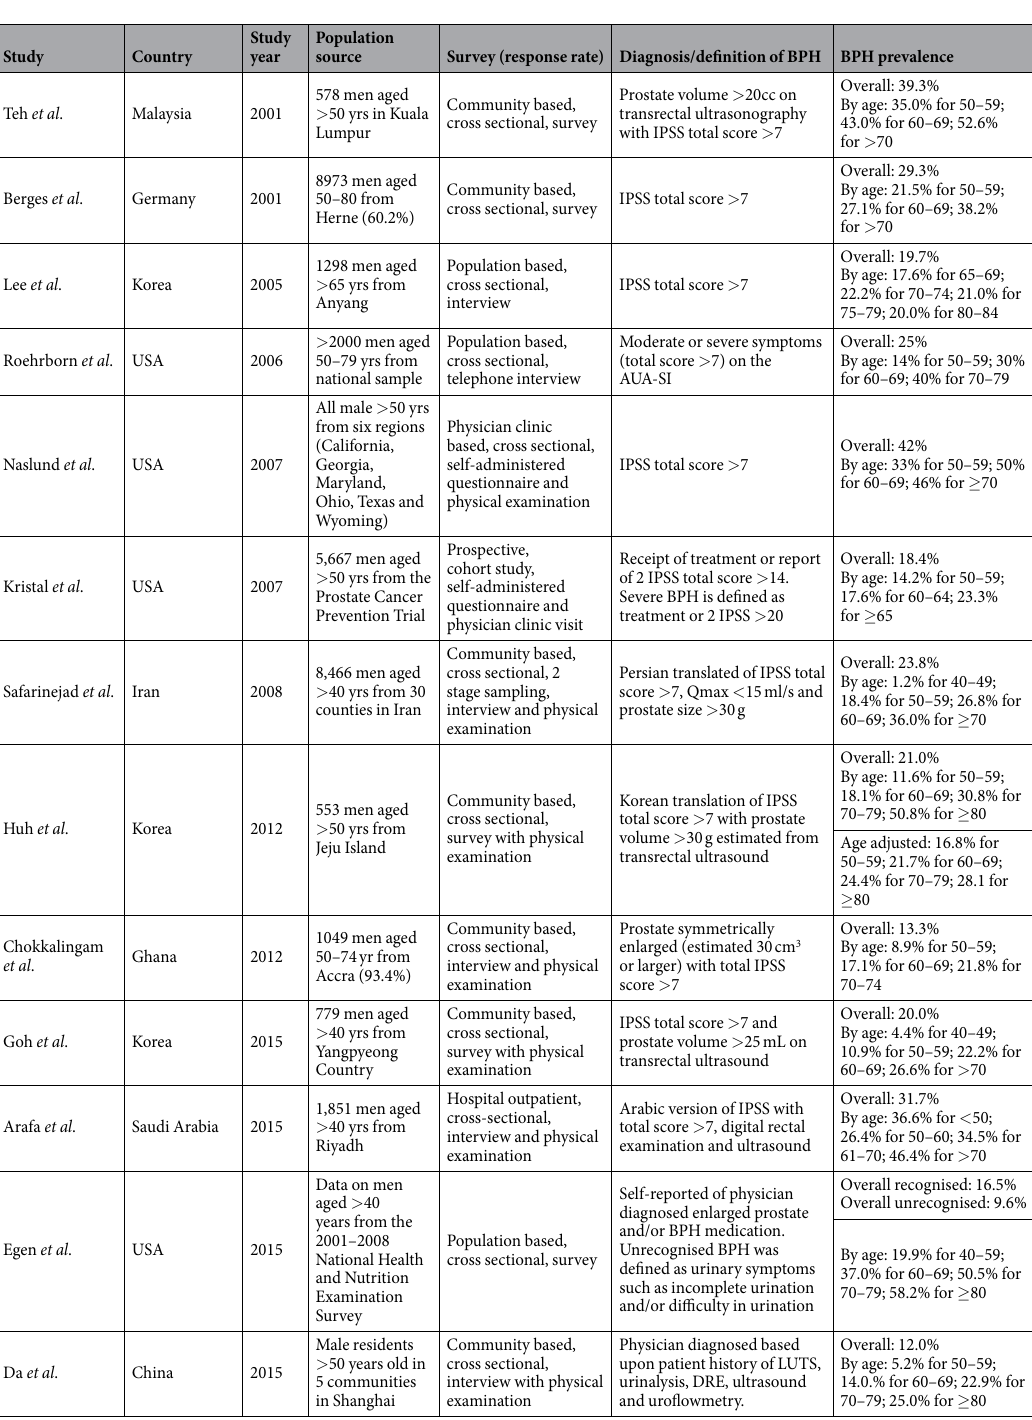
Table 1. Summary of studies which examined the prevalence of benign prostatic hyperplasia. AUA– American Urological Association. BPH- benign prostatic hyperplasia. DRE – Digital rectal examination. IPSS – International prostate symptom score. LUTS – Lower urinary tract